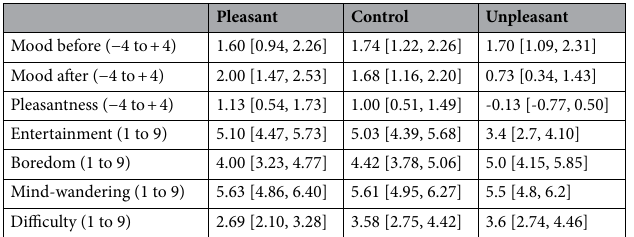
Table 4. Ratings (mean, 95% CI) in the thinking aid conditions. Numbers in round brackets indicate the rating scale from low to high.